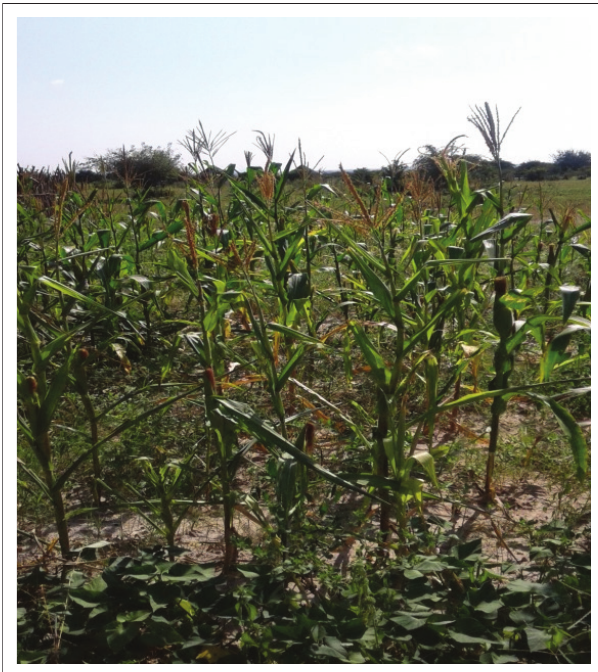
FIGURE 2: Rain-fed maize crops in Tigere